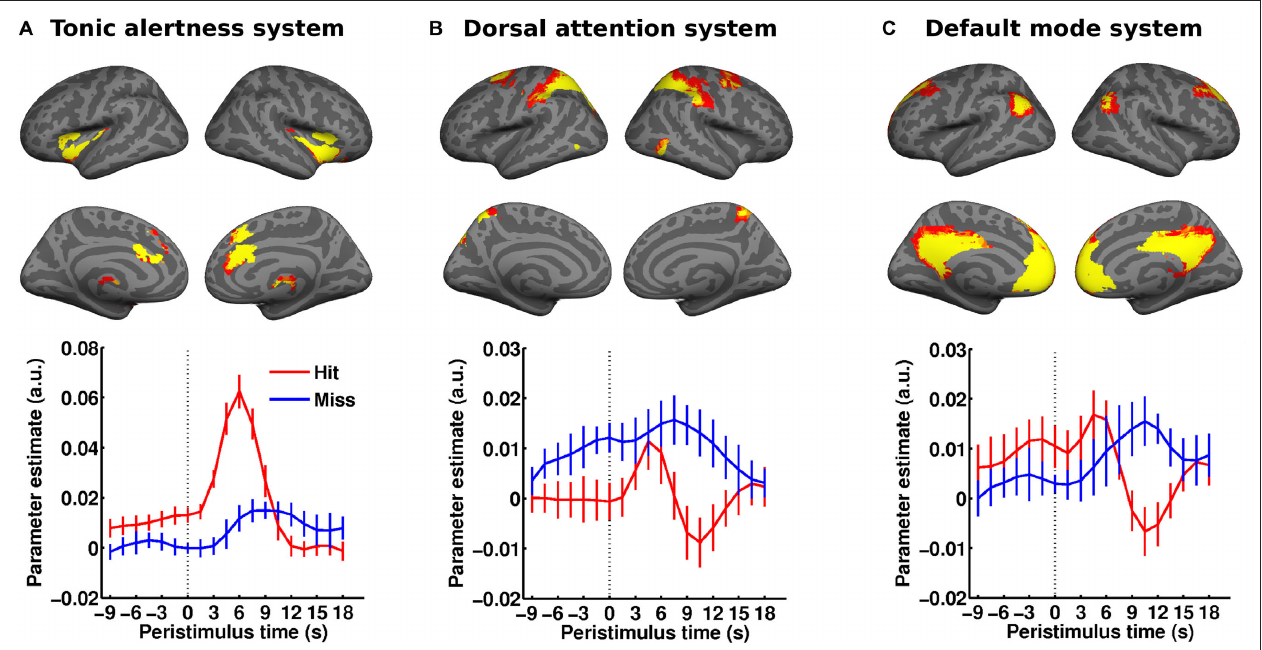
FIguRe 2 | Distributed ongoing activity fluctuations in large-scale ICNs impact perceptual performance. (A–C) Subjects performed a free-response auditory detection task (cf. Figure 3A ). The pre-stimulus BOLD signal (dotted vertical line marking stimulus onset) from three ICNs (rendered on a canonical inflated cortical surface) was examined as a function of perceptual outcome. Hits were preceded by significantly higher pre-stimulus activity in the tonic alertness